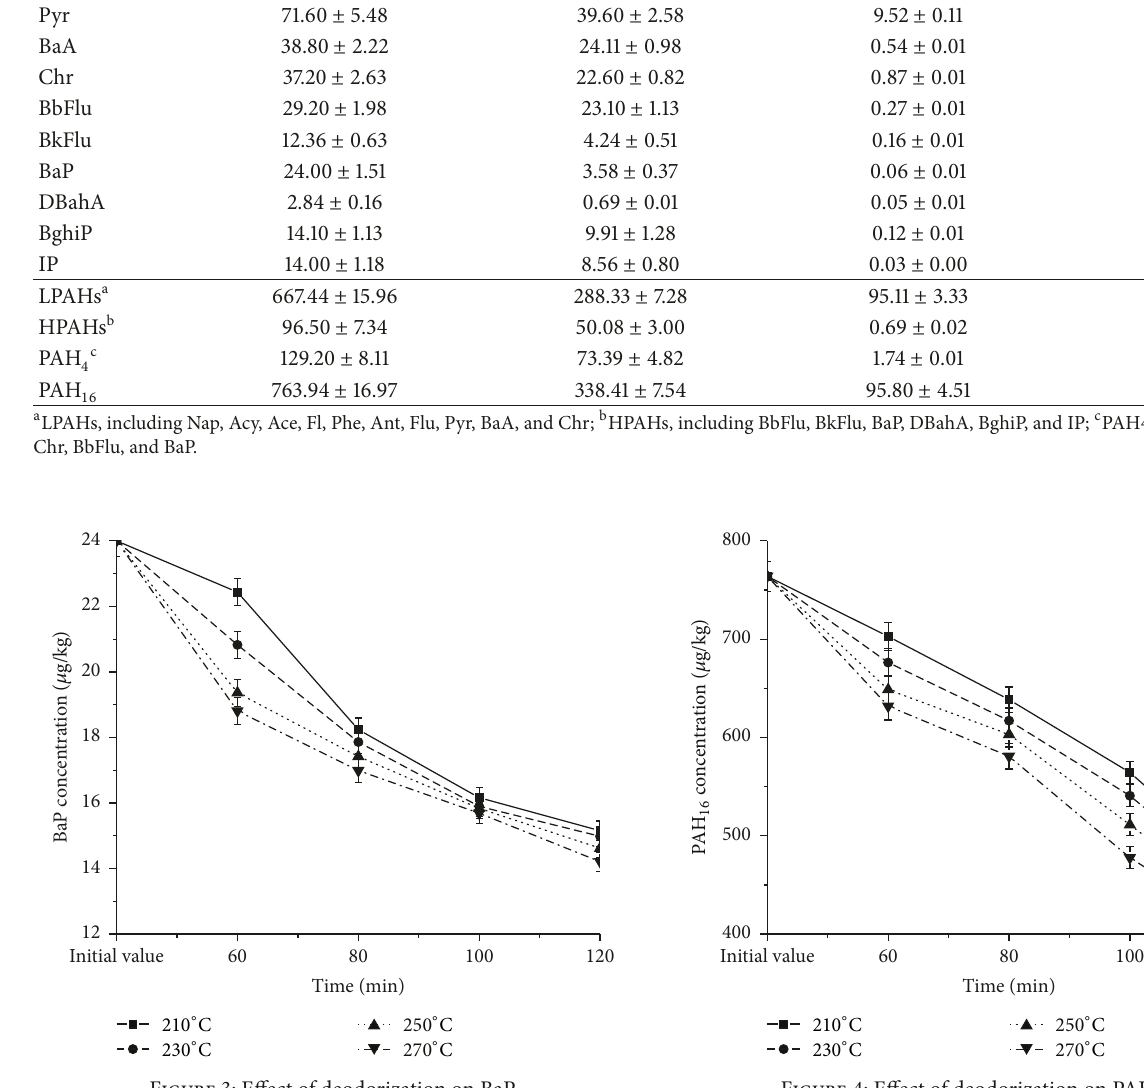
Determination of other intermediary oils (neutralized, bleached, and deodorized oils) revealed that all analytes showed reduction in their levels (see Table 4). Percent reduc- tions of intermediary oils were relative to the initial crude oil levels. As a whole, bleaching with WYACc was the most efficient means to eliminate PAHs in crude oil, while